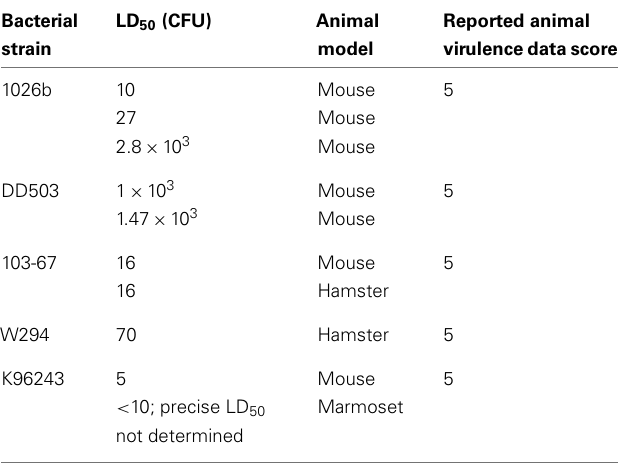
Table 3 | Burkholderia pseudomallei strains with animal models of aerosol